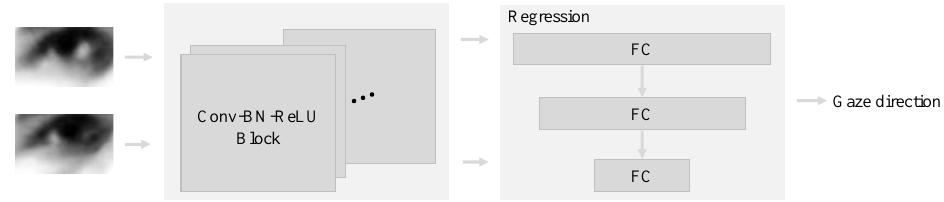
Figure 9. Example of a two-stream model. The feature extractor module is based on convolution layers. Regression module is represented by fully connected layers.